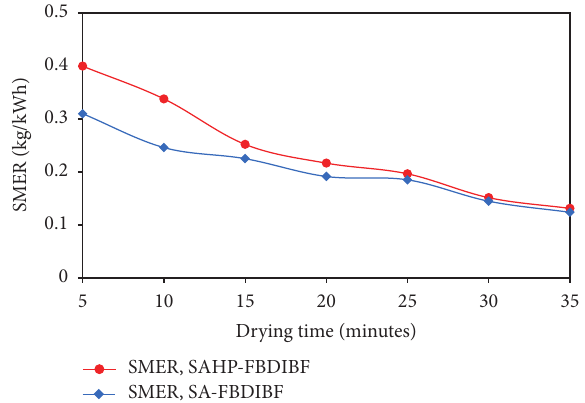
Figure 21: The variation of SMER with drying time.